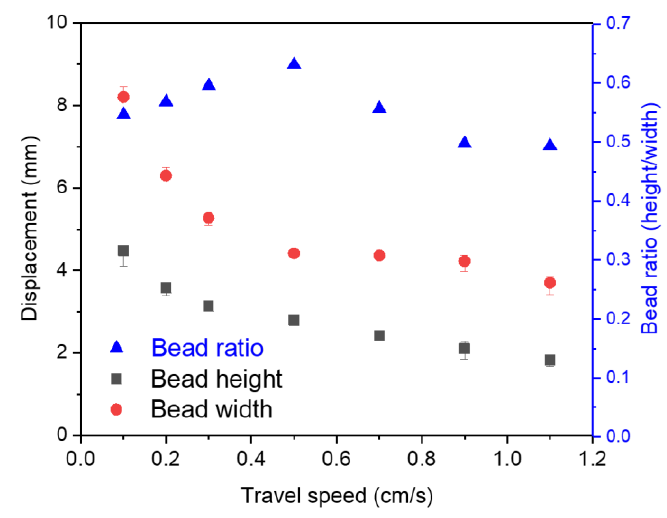
Figure 10. Bead height, width, and aspect ratio with various travel speed .